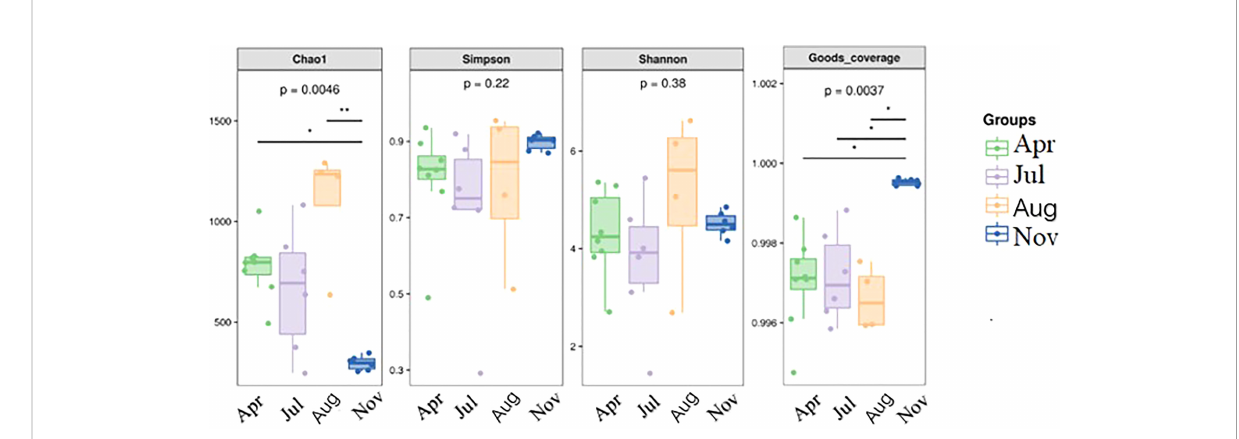
FIGURE 1 Differences in the Alpha Diversity Index of Meretrix meretrix Samples during different seasons.